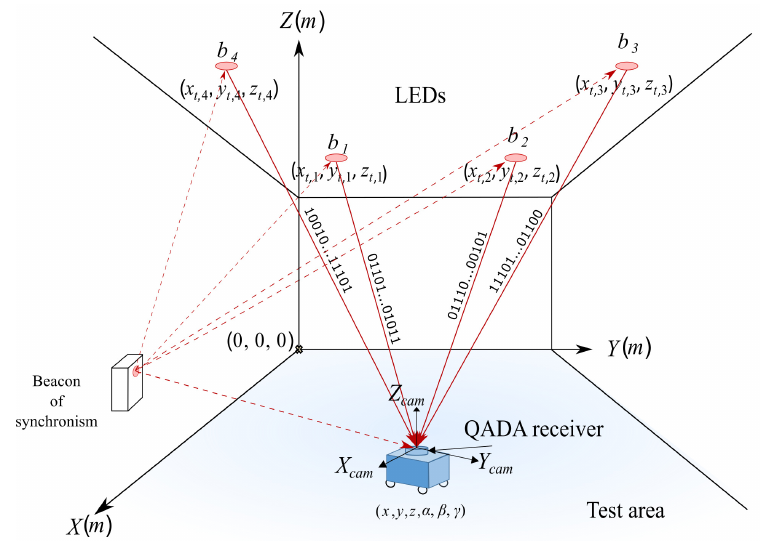
Figure 1. Global overview of the proposed